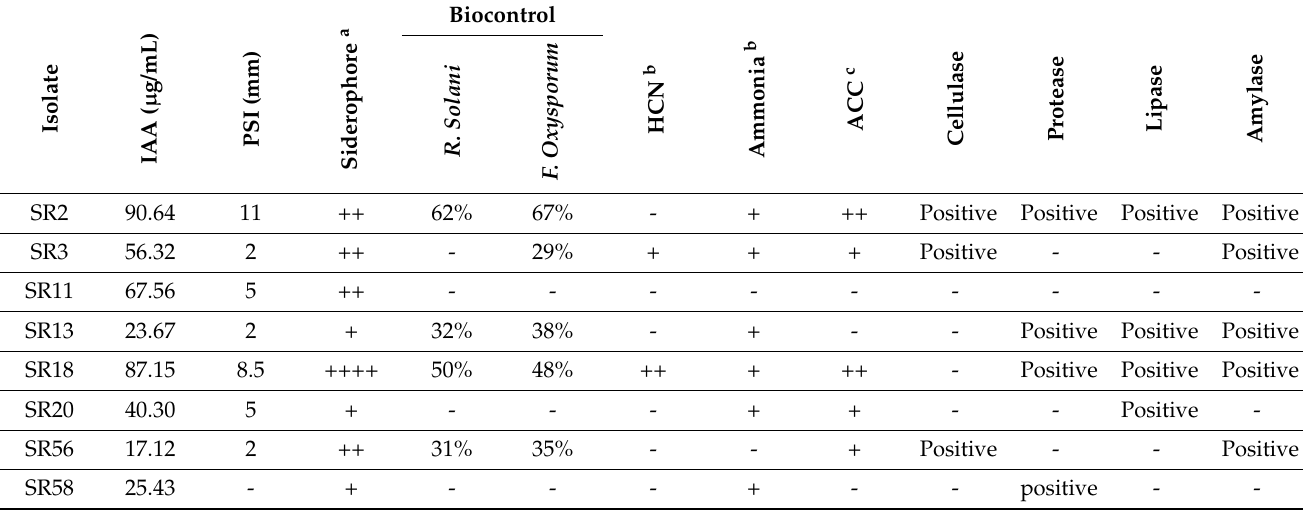
Table 1. Multifarious PGP traits of potential Bacillus spp. isolated from soils of the IGP